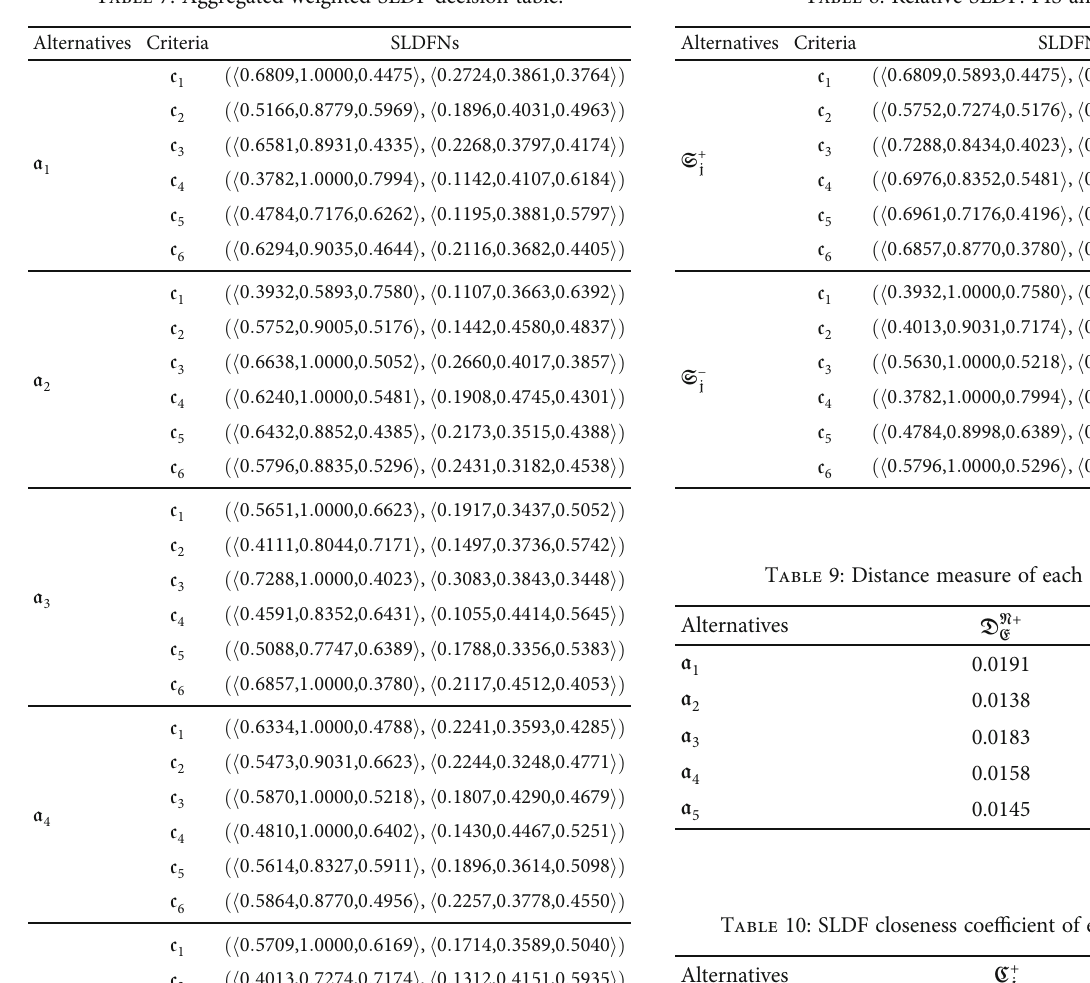
Table 7: Aggregated weighted SLDF decision table. Table 8: Relative SLDF: PIS and NIS.